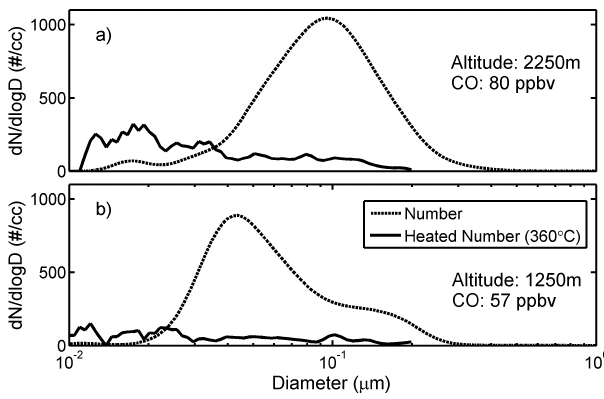
Fig. 1. Examples of DMA distributions in the FT from RF08 for a Fig. 1: Examples of DMA distributions in the FT from RF08 high and low CO layer before (dotted) and after heating to 360 ◦ C for a high and low CO layerbefore (dotted) and after heating to 360 ◦ C (solid).